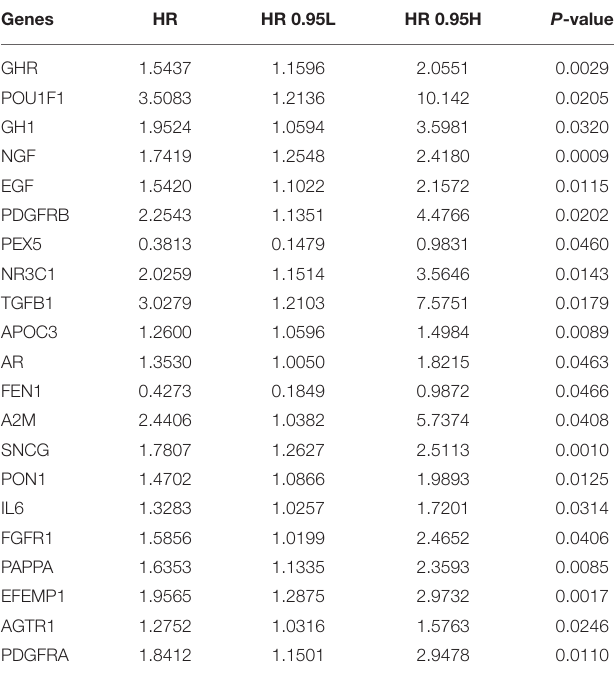
TABLE 2 | Prognostic aging-relevant genes in gastric cancer with univariate-cox regression analyses. Genes